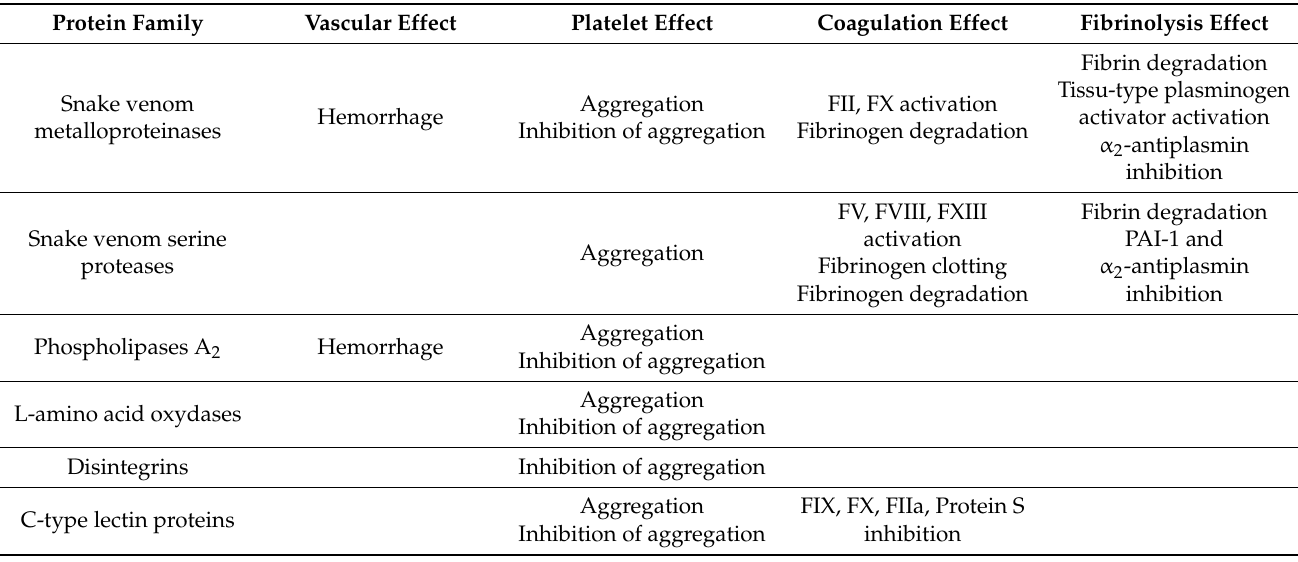
Table 2. Points of hemostasis targeted by the different families of proteins isolated in Bothrops venoms. Protein